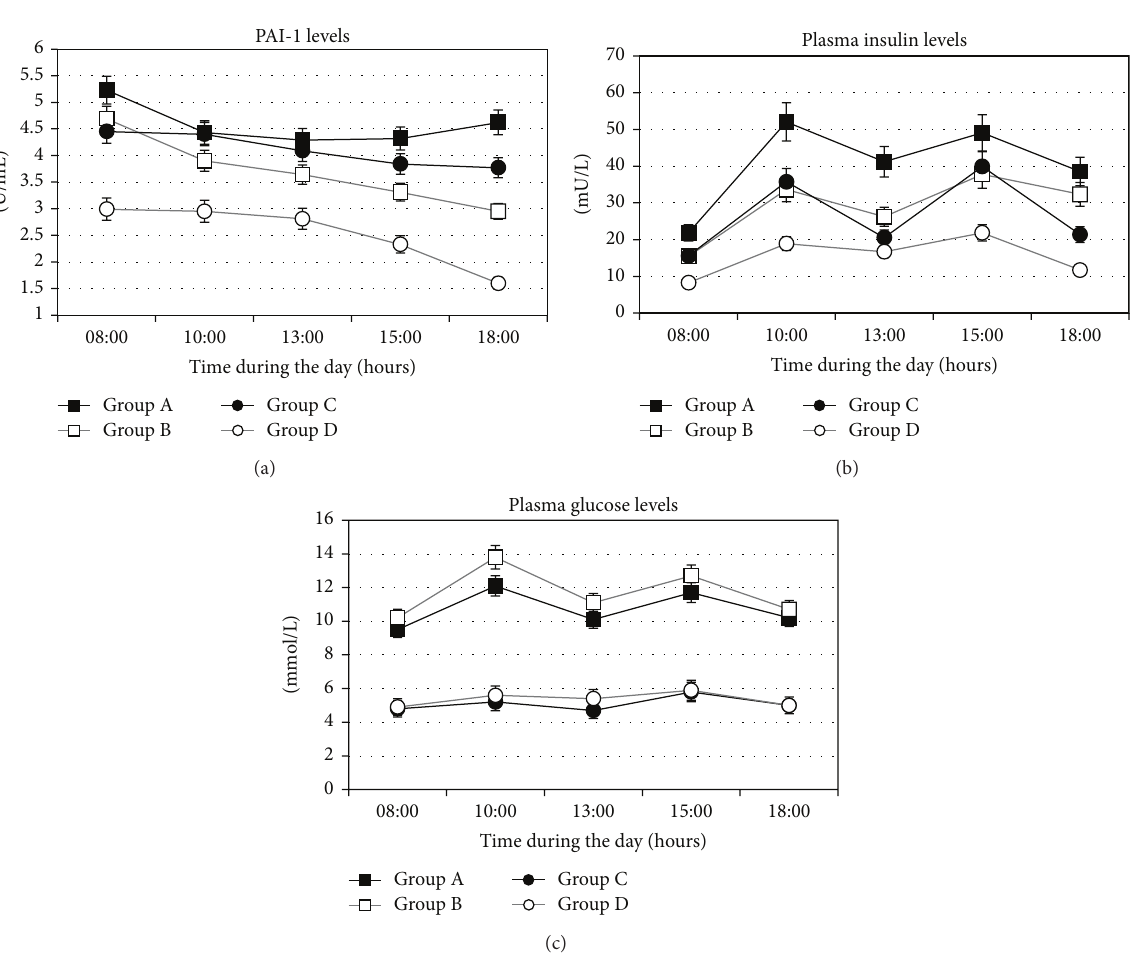
Figure 1: Daily profile of PAI-1 activity (a), plasma insulin (b), and plasma glucose (c) levels in T2D patients with CAD (group A), T2D without CAD (group B), nondiabetics with CAD (group C), and healthy controls (group D). Data are means ±